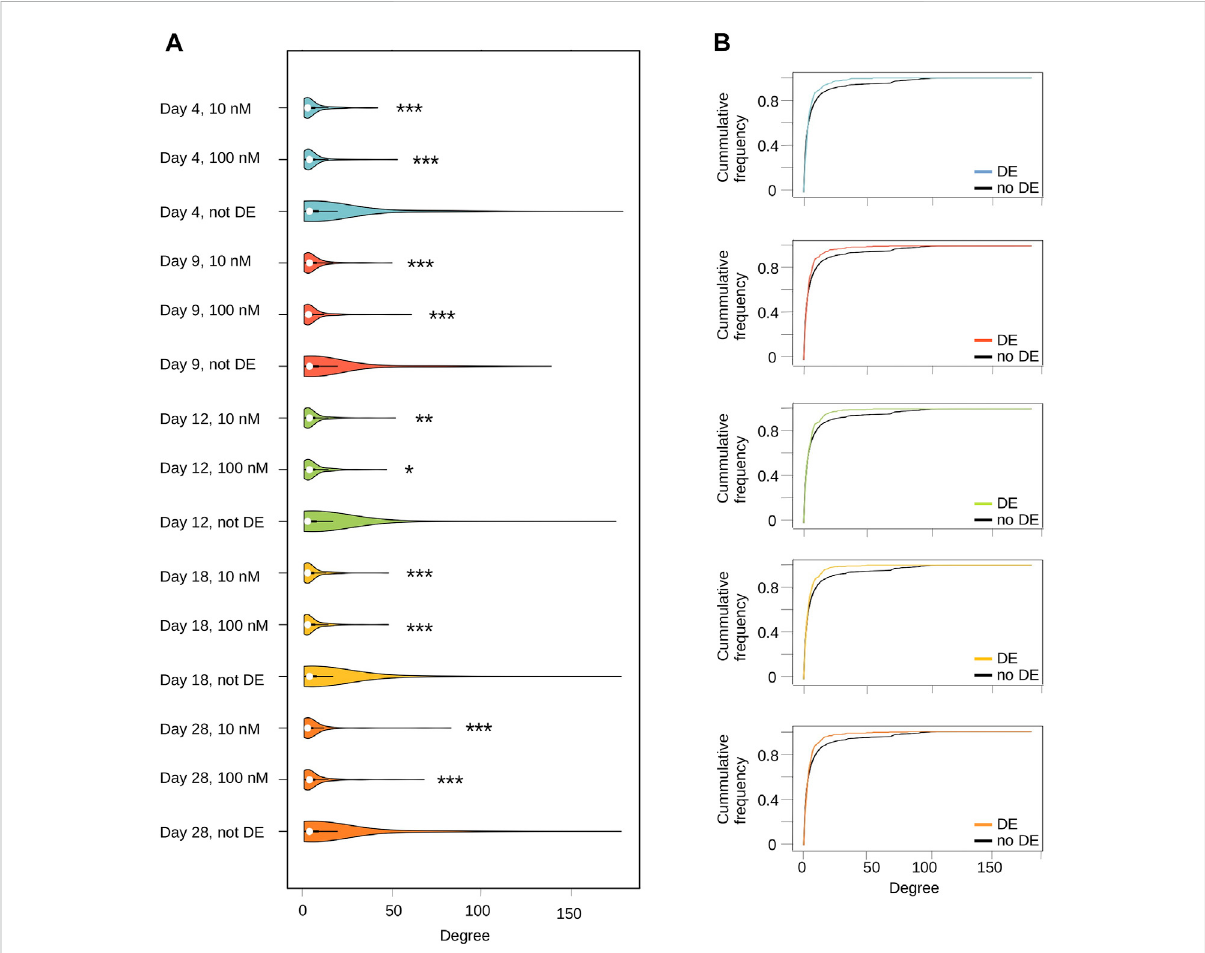
FIGURE 3 Transcriptome alterations induced by TBBPA are not randomly distributed in biological networks. (A) Connectivity (degree) distribution of DE genes versus no-DE, at each time point. * pval ≤ 0.05, ** pval ≤ 10 – 2 , *** pval ≤ 10 – 3 . (B) Cumulative proportion of network nodes relative to their degree (Empirical Cumulative Distribution Function). DE genes are always located above non-DE genes, indicative of a higher proportion of poorly connected